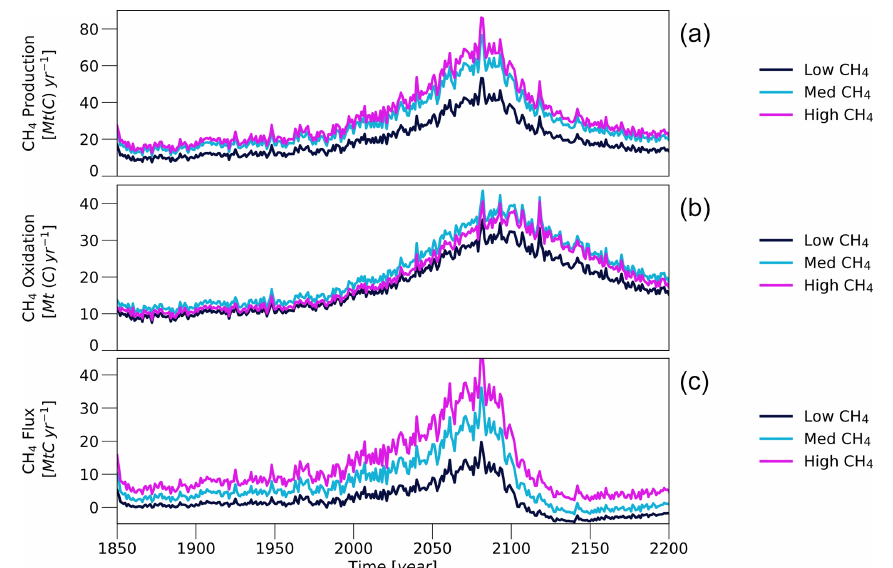
Figure A4. Key parameters of the methane module. (a) Soil methane production in permafrost-affected regions simulated with different parameter combinations in the methane module that result in overall low (dark-blue line), medium (light-blue line) and high (magenta line) CH 4 emissions. The medium emission parameter combination was used for most of the simulations in the study and assumes a baseline fraction of CH 4 production of 0.4 and a Q 10 factor of 1.5. For the low-emission setup the baseline fraction of CH 4 was reduced to 0.35, and the Q 10 factor was set at 1.75. For the high-emission simulations the baseline fraction of CH 4 was raised to 0.45, and the maximum oxidation velocities were reduced by